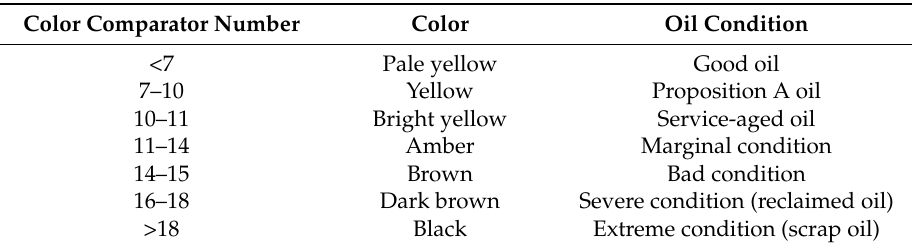
Table 1. Oil condition based on color comparisons